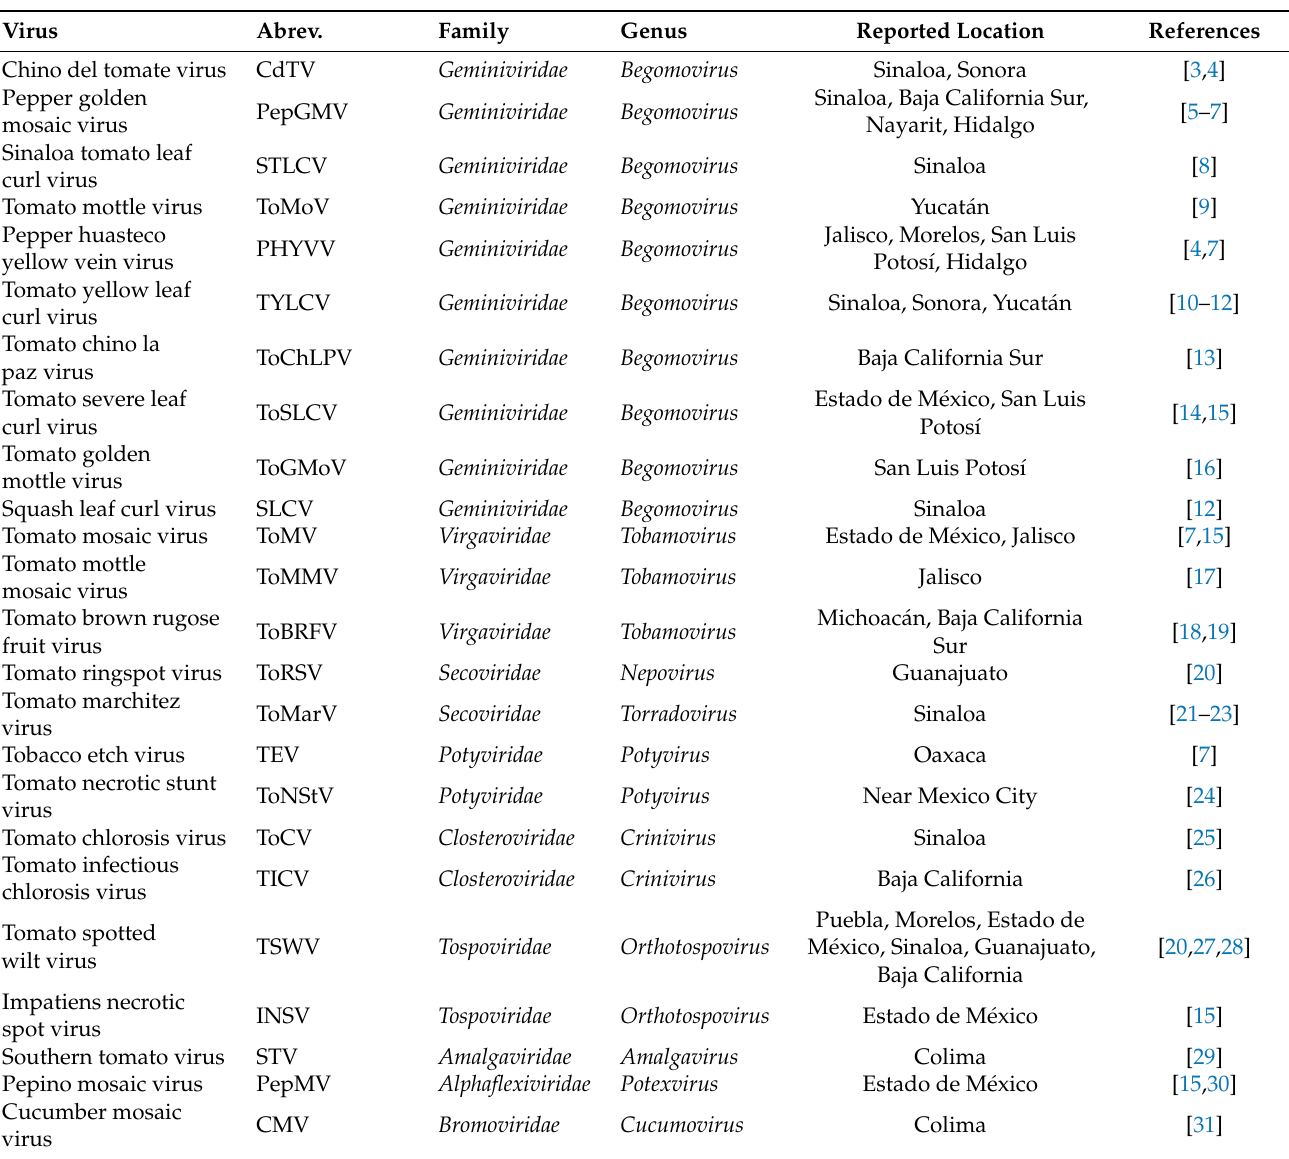
Table 1. Viruses reported on tomato crops in